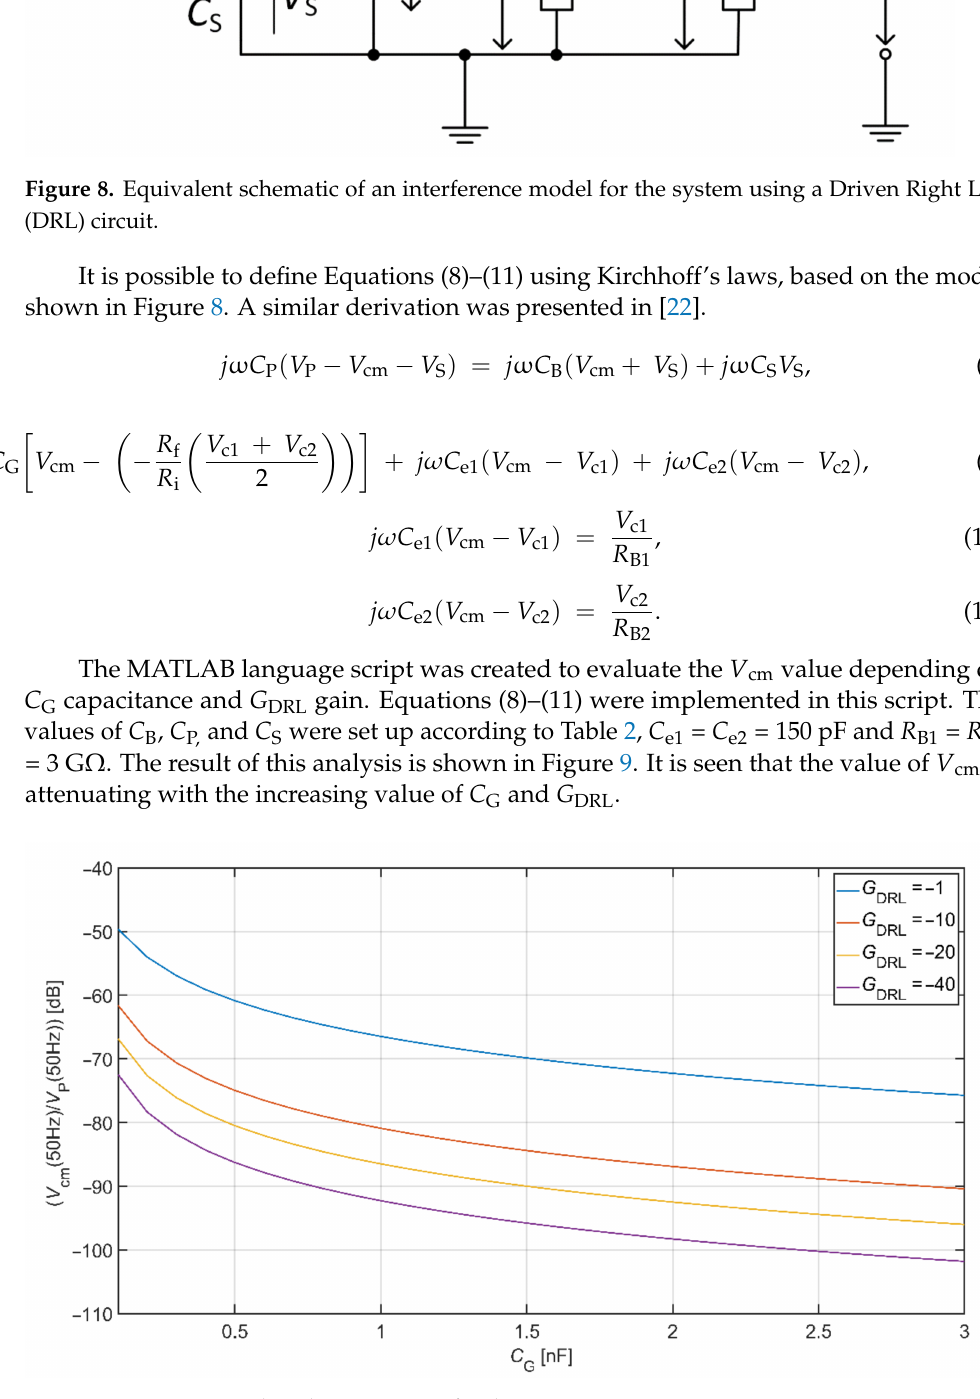
Figure 9. Common-mode voltage rejection for the system using a DRL